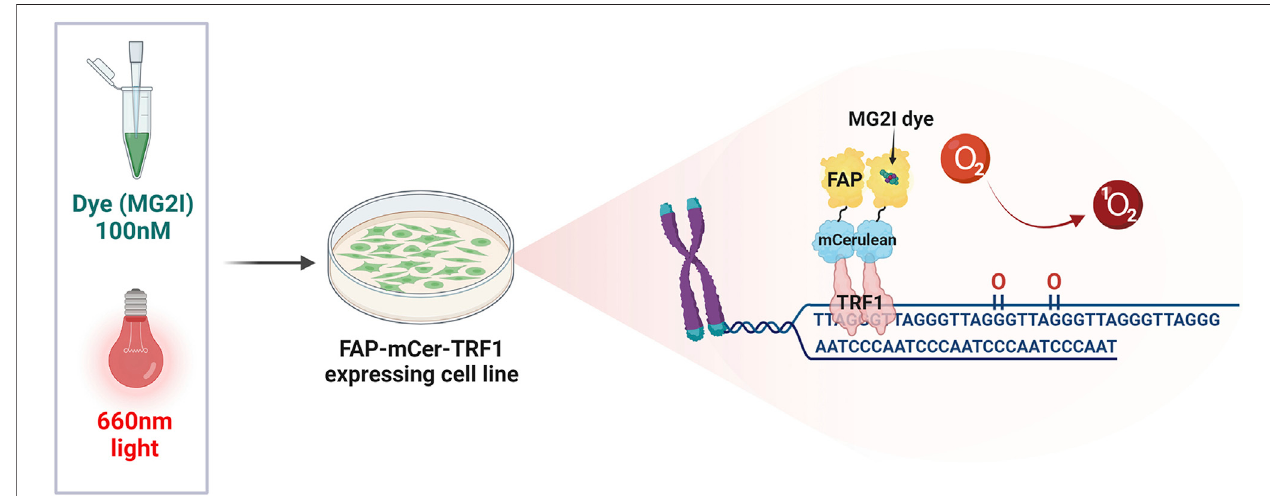
FIGURE 3 | The FAP-mCer-TRF1 system. The targeting tool that speci fi cally generates 8-oxoG at telomeres, consists of an overexpressed shelterin protein TRF1 fused with the fl uorogen-activating peptide (FAP), along with the fl uorescent protein m-Cerulean (mCer) to visualize expression. FAP-mCer-TRF1 expressing cells are preincubatedwith100 nMofthephotosensitizerdyedi-iodinatedmalachitegreen(MG2I),whichwhenboundtotheFAP,producessingletoxygen( 1 O 2 )uponexcitation with 660 nm light. The singlet oxygen then reacts speci fi cally with the telomeric guanines to generate 8-oxoG in a temporally and spatially controlled manner.